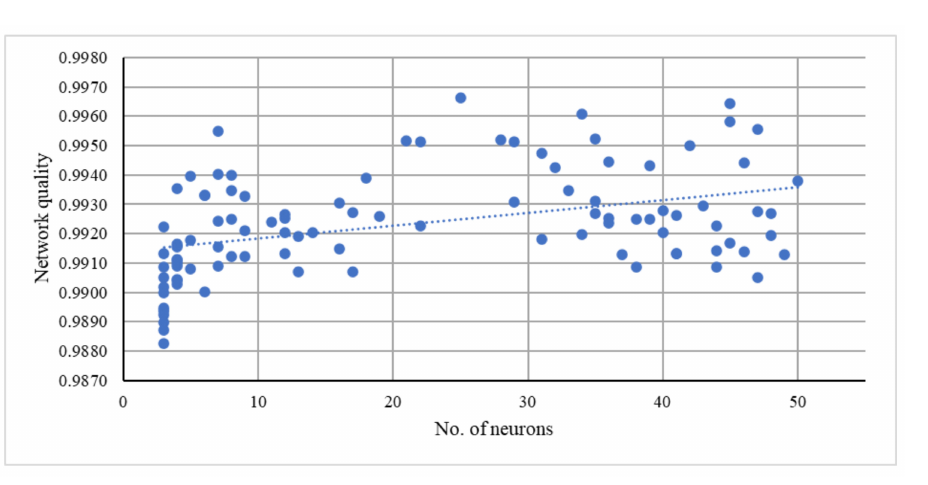
Figure A1. Influence of the number of neurons in the hidden layer on the quality of learning neural networks.